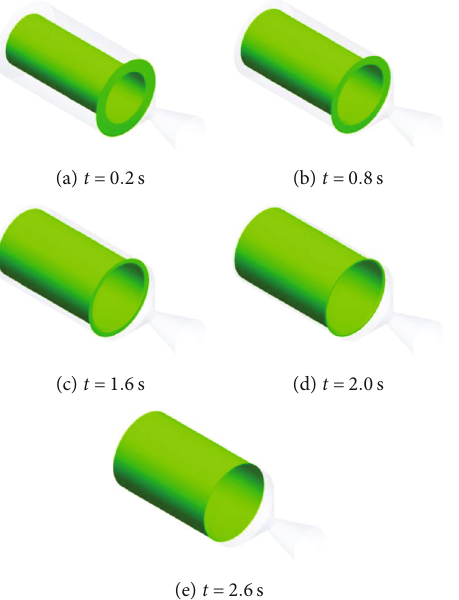
Figure 9: Schematic diagram of burning surface regression.